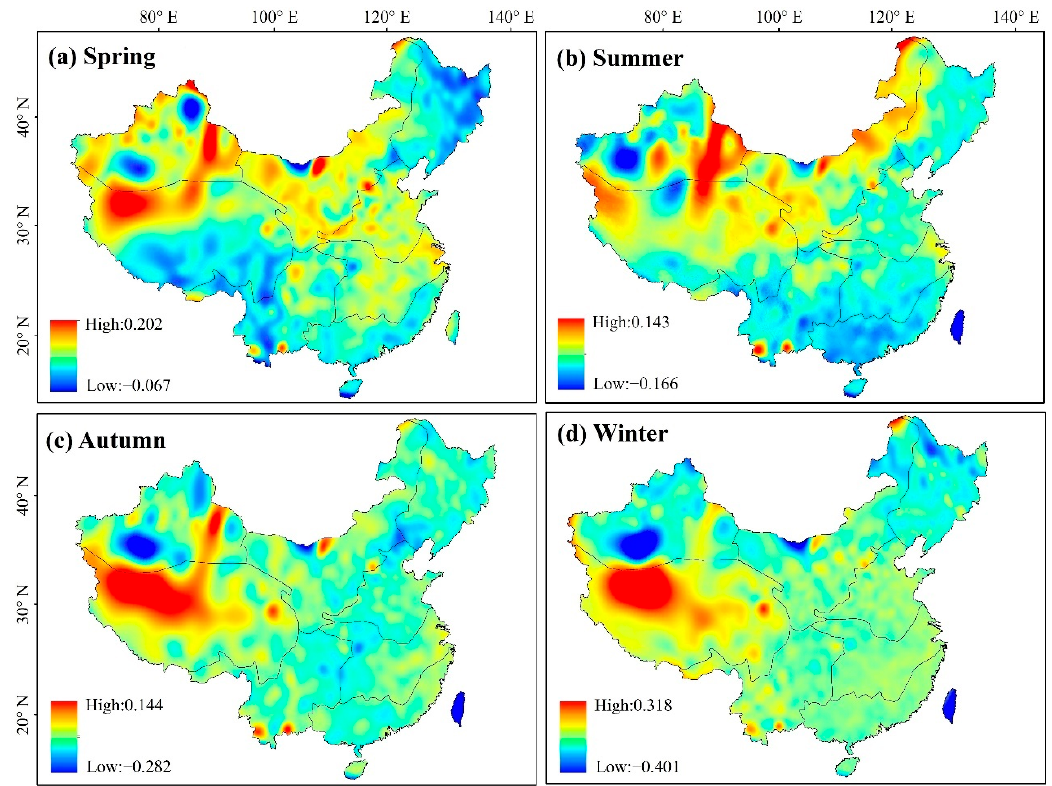
Figure 9. Spatial distribution of seasonal variation trend of temperature from 1982 to